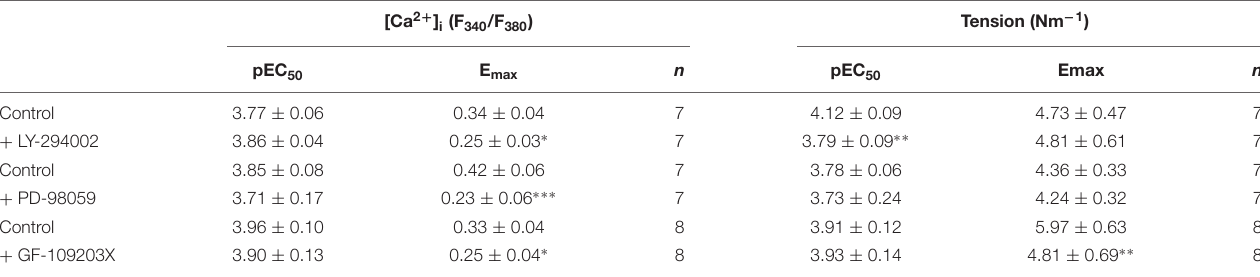
TABLE 1 | Effects of the inhibitors of PI3K LY-294002 (3 µ M), ERK-MAPK kinase PD-98059 (3 µ M) and PKC GF-109203X (0.1 µ M) on the sensitivity and maximal responses of the CaCl 2 concentration-response curves in mesenteric arteries stimulated by PE (10 µ M) in a Ca 2 + -free medium. [Ca 2 + ] i (F 340 /F 380 )